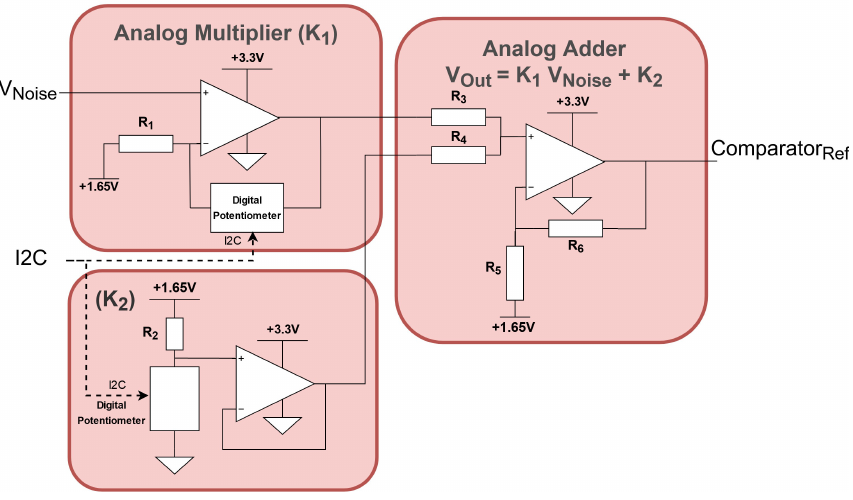
Figure 12. Alternative circuit diagram for comparator reference adjustment. Compared with other parts of the analog front-end, the comparator reference adjust- ment power consumption is too high and needs to be reduced. There is another way of proceeding, less power consuming and more versatile: using an ultra-low power digital processor used to acquire average sea noise level V Noise with an analog to digital converter (ADC) at a low sampling frequency rate. Then, computing V Ref is done digitally and converted into an analog value entering the comparator, using an ultra-low power Digital Analog Converter (DAC). These operations are implemented using an ultra-low power system on chip ( CC2652 [39]) with a circuit dedicated to low frequency operations, named sensor controller . This circuit can be activated while the main processor is in sleep mode, leading to an ultra-low power consumption of 4 µ A for ADC conversion of average sea noise level at 0.1 Hz. A LTC1662 [40] DAC is used to convert the reference value transmitted by the sensor controller in SPI to an analogical value. Corresponding power consumption is 1.5 µ A, leading to an overall consumption of 5.5 µ